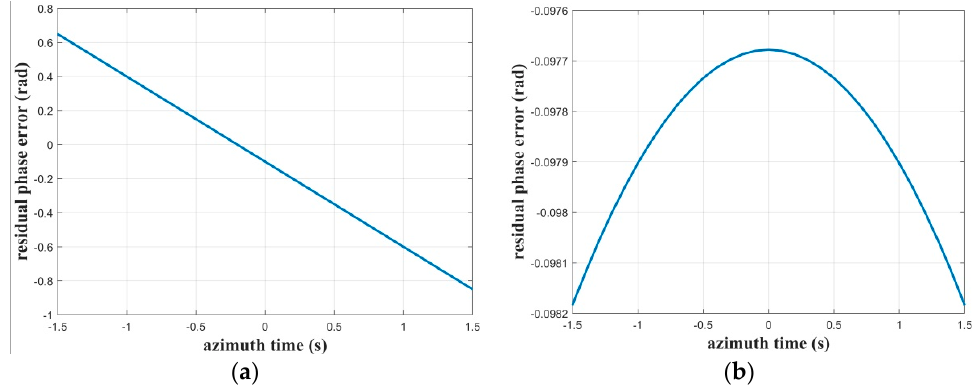
Figure 4. Residual phase deviations of P r with two different computation methods. ( a ) residual phase deviation with Equation (22). ( b ) residual phase deviation with Equation (25).